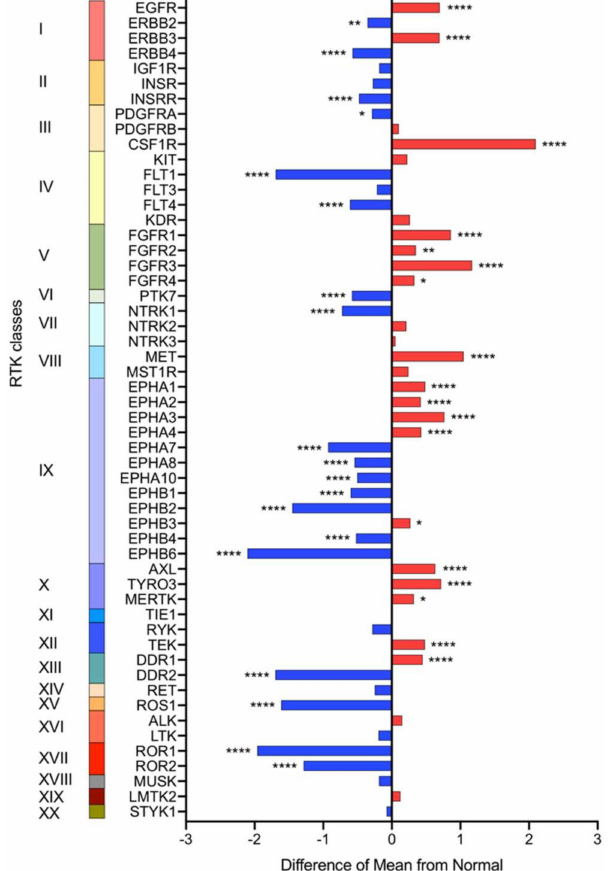
Figure 2. Pairwise comparison of RTKs between CCA and normal tissues. The gene expression of 54 RTKs from 20 different classes were compared between CCA and normal tissues. The difference in mean expression of each RTKs in CCA tumors ( n = 704) from normal tissues ( n = 165) were calculated and plotted as a bar graph. The RTKs with higher mean expression in CCA than normal tissues are indicated with red bars whereas the RTKs with lower mean expression are indicated with the blue bars. The method for differential analysis between tumor and normal was one-way ANOVA testing followed by Holm-Sidak post-hoc analysis. * p < 0.05, ** p < 0.01, **** p <